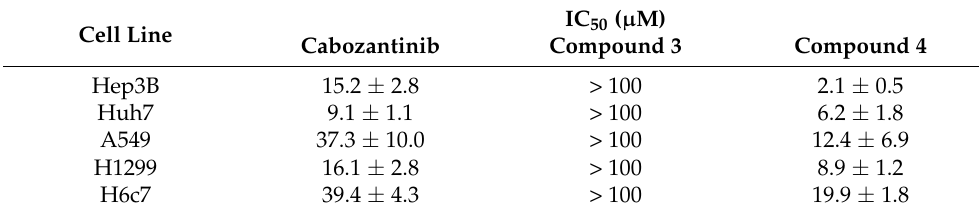
Figure 3. Inhibitory activity of cabozantinib compounds 3 and 4 on cell proliferation and viability. Table 2. IC 50 values against cell proliferation and viability a .